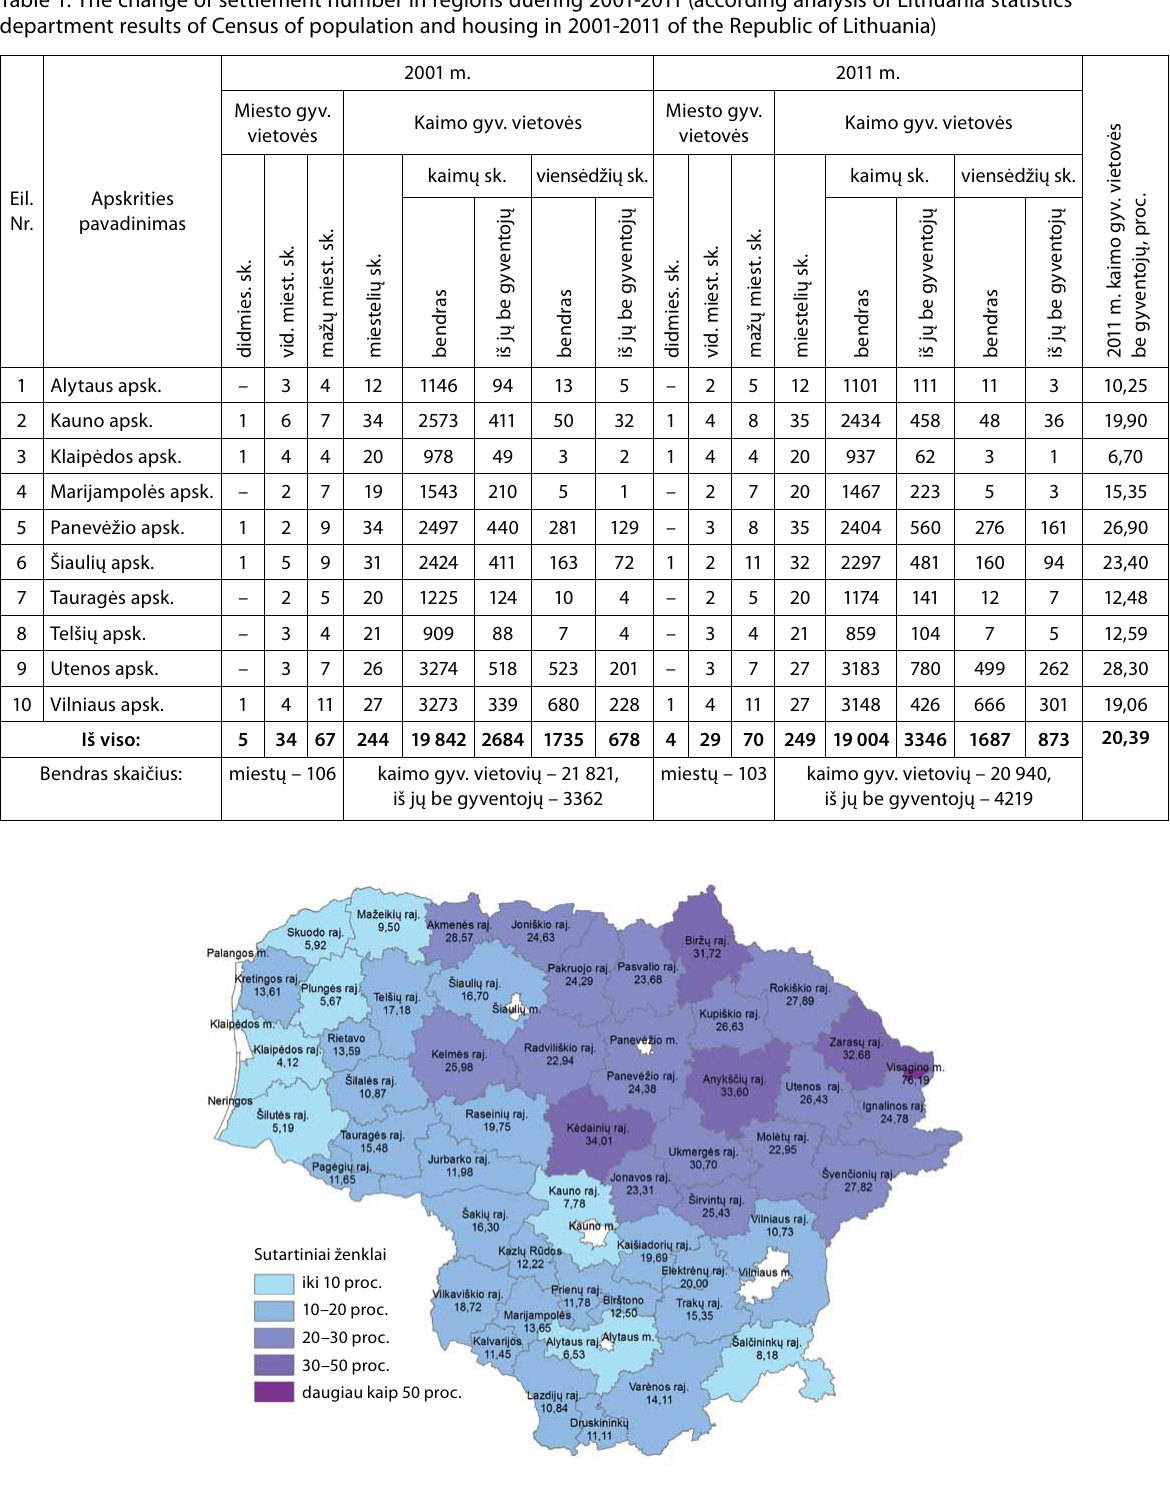
Table 1. The change of settlement number in regions duering 2001-2011 (according analysis of lithuania statistics department results of Census of population and housing in 2001-2011 of the republic of lithuania) 2001 m.